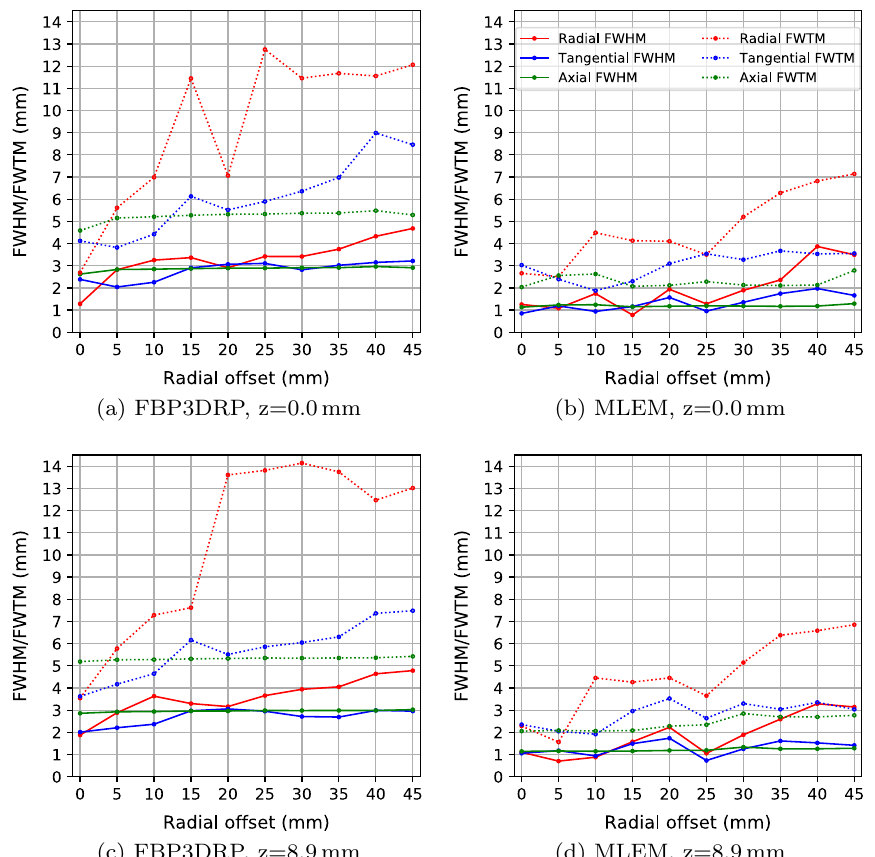
Fig. 1 Spatial resolution in radial, tangential and axial directions for the point source located in the center of the axial FOV ( a , b ) and at one forth of the axial FOV ( c , d ). The image reconstruction methods are